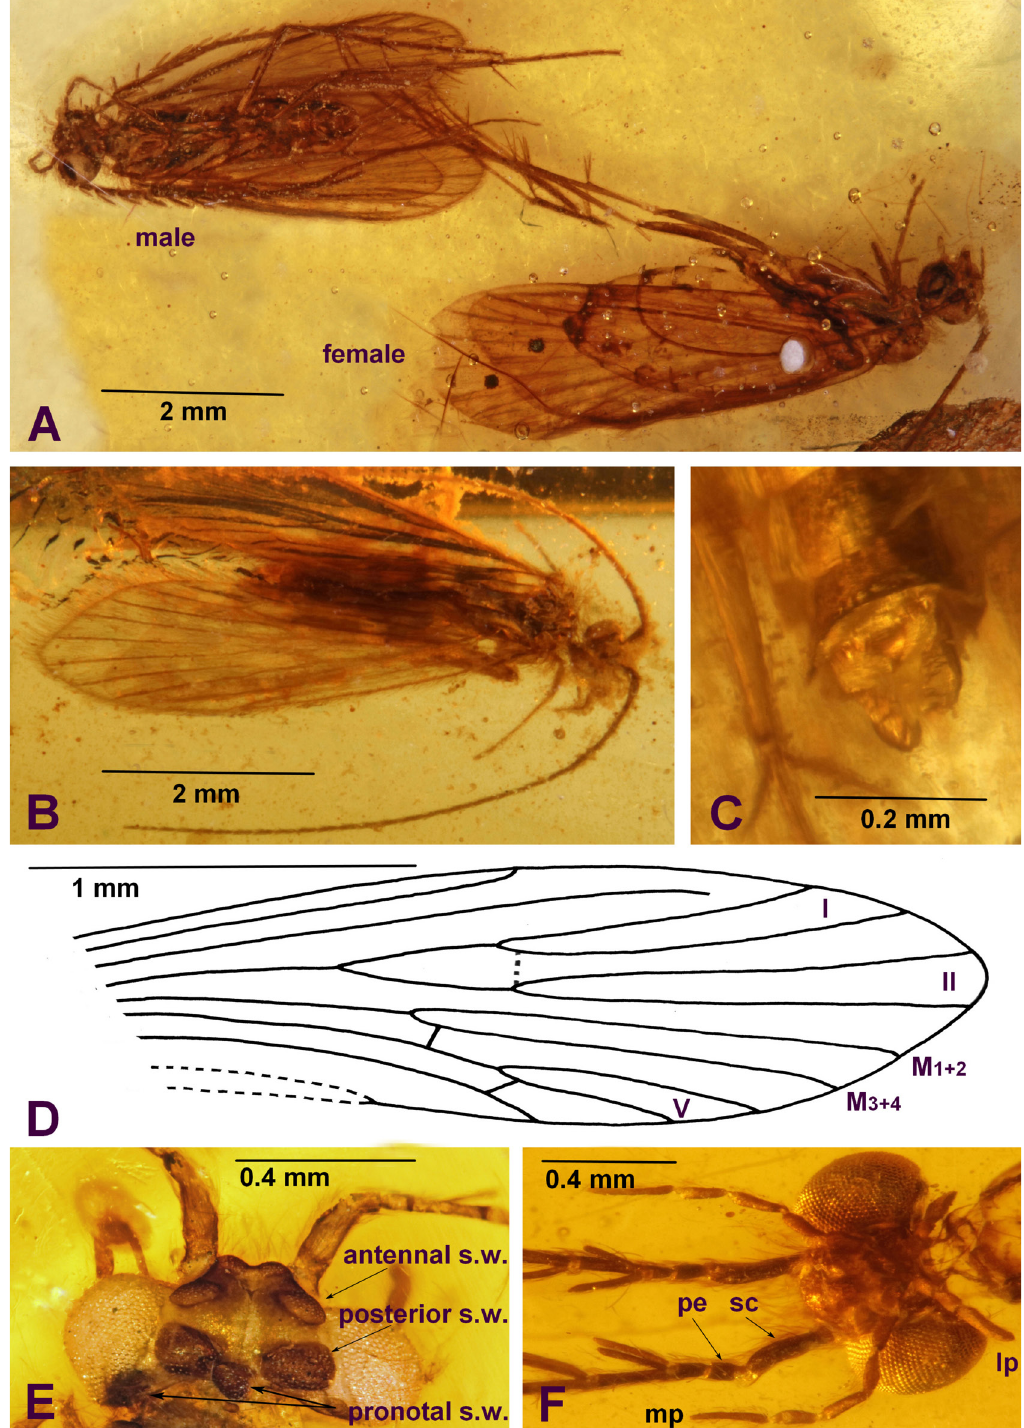
Fig. 4. Palaeopsilotreta xiai Wichard & Wang, 2017. A . Male and possible female in one Baltic amber piece (ZFMK-TRI000815). B . Female with simple, filiform antennae in dorsal view (ZFMK-TRI000816). C . Female genitalia, as far as visible in cloudy amber (ZFMK-TRI000816). D . Drawing of female forewing. E . Head of male (ZFMK-TRI000811) in dorsal view with antennal, posterior and pronotal setose warts (s.w.). — F . P. burmanica sp. nov. (ZFMK-TRI000813), head of male with maxillary palps (mp), labial palps (lp) and basal bipectinate antennae with scapus (sc) and pedicellus